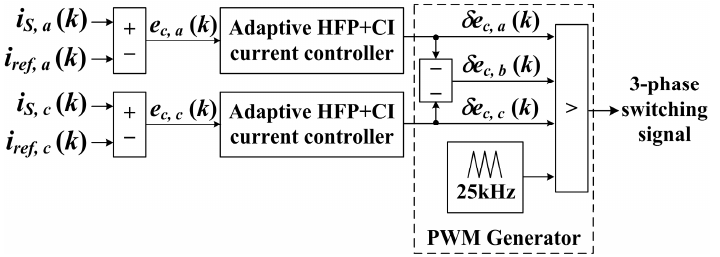
Figure 2. Proposed CCA for 3 ‐ phase operation.